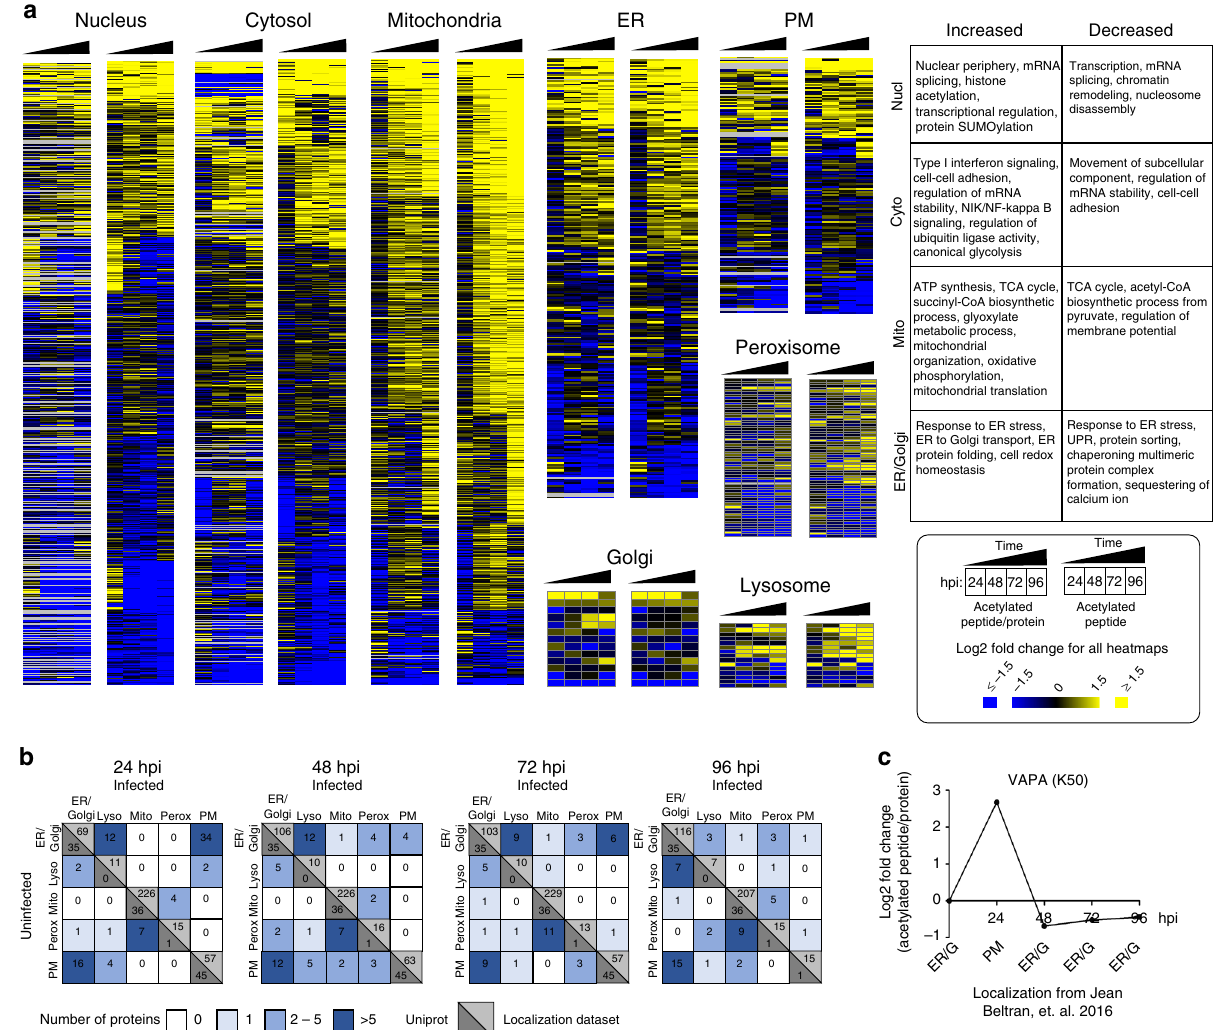
Fig. 4 Acetylation in the context of temporal subcellular localization and translocation during infection. a Heatmaps visualizing temporal changes in peptide acetylation levels (right) and acetylation normalized to protein abundance (left) in the nucleus, cytosol, mitochondria, ER, Golgi, plasma membrane (PM), peroxisome, and lysosome. Representative biological processes overrepresented in clusters of increasing and decreasing acetylations within speci fi c subcellular compartments are shown. b Predicted localizations of the identi fi ed acetylated proteins in uninfected (mock) cells (vertical) are compared to the localizations of the proteins at 24, 48, 72, and 96 hpi (horizontal) (from Jean Beltran, et al. 2016 20 ). Numbers in the upper, light gray triangles along the diagonals indicate non-translocating proteins annotated from 20 , and those in the lower, dark gray triangles indicate proteins annotated from Uniprot. Boxes displaced from the diagonal designate predicted putative translocating protein localization at given time points during infection. Numbers of translocating proteins are indicated by color code. As an example, of the proteins assigned to the ER/Golgi in uninfected cells, 34 were assigned as translocated to the PM at 24 hpi. c Example of a protein translocating from ER/G to PM at 24 hpi. A change in protein acetylation is also observed at 24 hpi. Peptide acetylation levels normalized to protein abundance are represented in parallel with organelle subcellular localization (assigned from 20 ) at each infection time